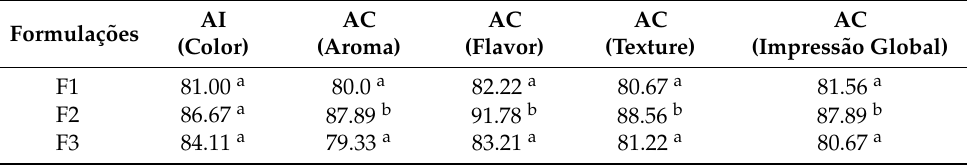
Table 5. Acceptance index (AI) for the different formulations of the bars. AI AC Formulaç õ es (Color)